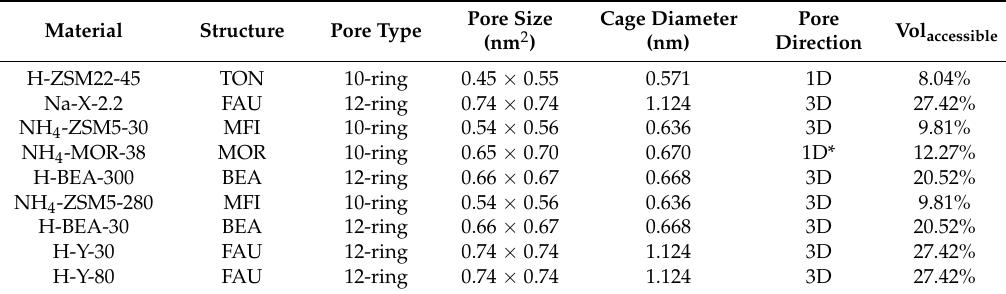
Table 7. Structure and framework properties of the different zeolite types. Structure refers to the official framework type of the zeolites, pore size are the dimensions of the largest (accessible) pore in the material [22]. Cage diameter is the diameter of the internal cages, pore direction refers to the amount of dimensions the pores span and Vol accessible refers to the percentage of accessible volume in the zeolite framework (theoretical value based on complete framework) [43].